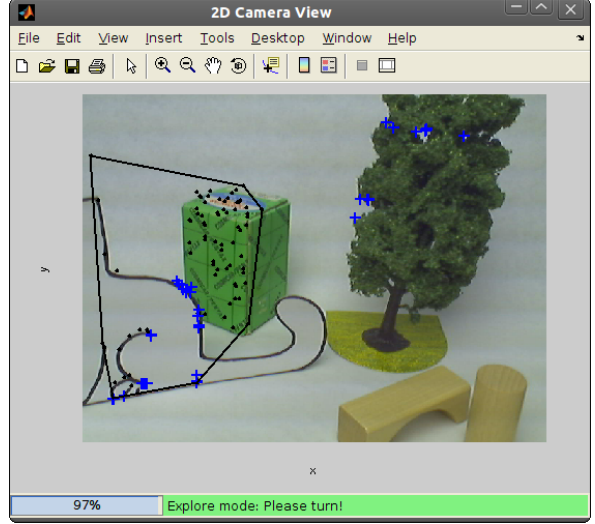
Figure 6: The proposed camera framework on a real example in both possible modes. The camera image is overlaid with task- specific annotations. The status bar displays the task for the op- erator and the progress he is